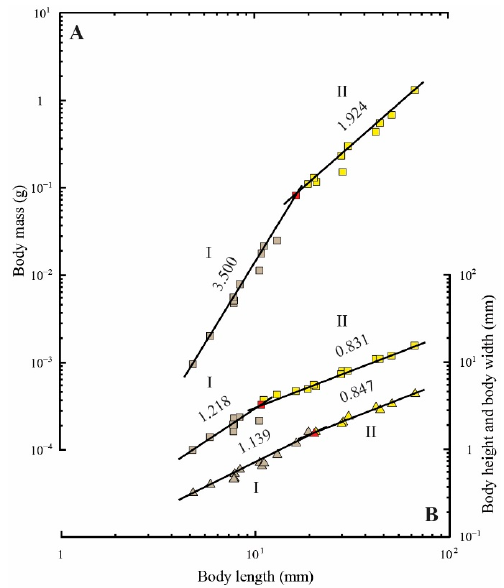
Figure 5. Allometric relationships between the body length and body mass (colored squares) ( A ); mean body height (colored squares) ( B ); mean body width (colored triangles) ( B ). The values above the regression lines indicate their slopes. The ontogenetic phase shifts are presented in two colors (gray, phase I; yellow, phase II). The red-colored spots indicate the measurements that overlap between phases I and II and between phases II and III. Table 3. Regression analyses of the allometric relationships (Y = α L β ) between body length (L) and body mass, mean body height, and mean body width (Y).